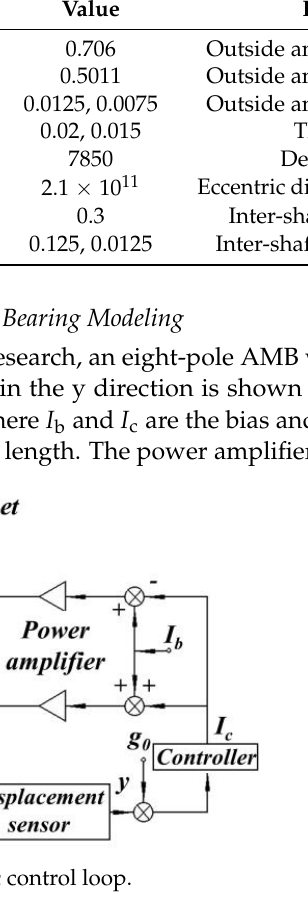
Table 1. The main parameters of the MSDS.